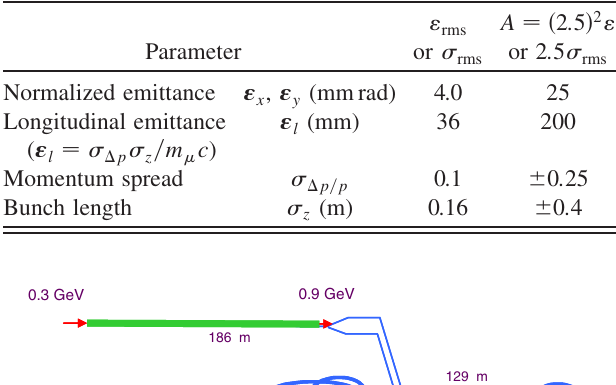
TABLE III. Beam emittance/acceptance after the cooling channel at 273 MeV =c . Note that the longitudinal normalized . acceptances are defined as 2 : 5 (cid:11) rms